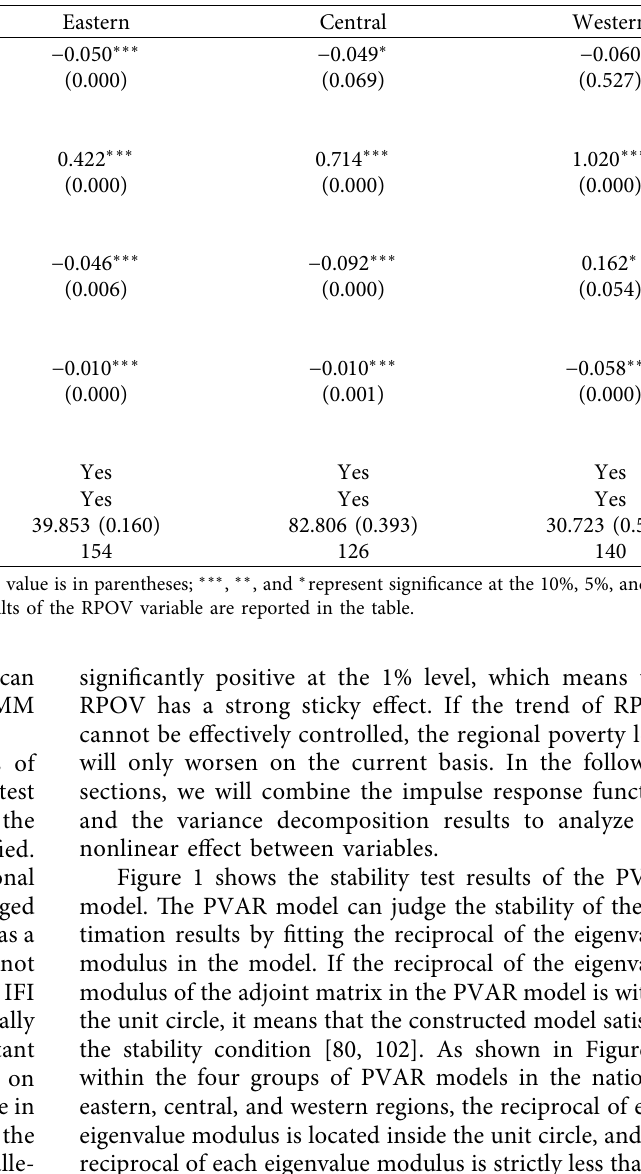
Table 3: GMM estimation results of the PVAR